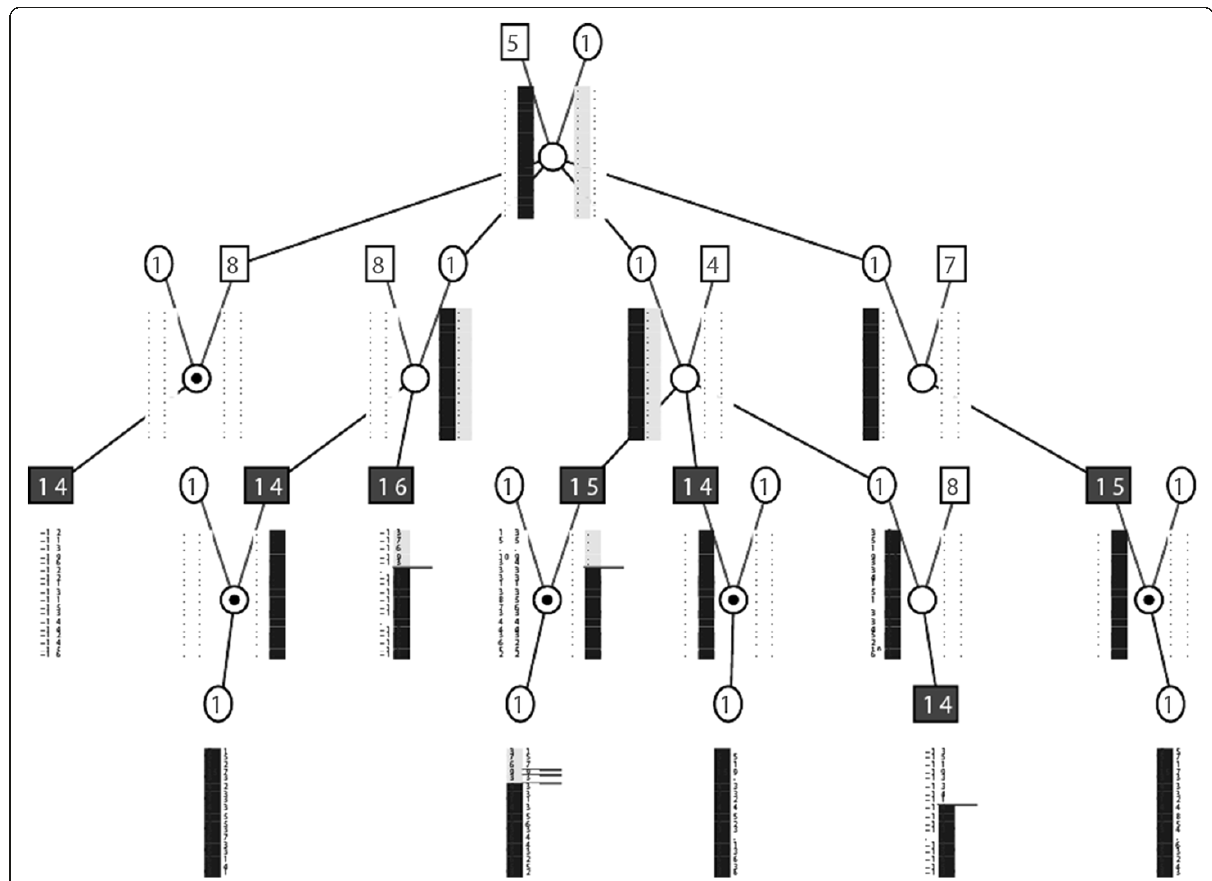
Figure 2 Pedigree that exhibits both potential male-to-male transmission and potential maternal inheritance of prostate cancer. In this family, with a maximum LOD of 1.7 in the HPCX region, all five maternally related affected males share a linked haplotype (shaded black) in this region and the one paternally-related affected male does not share this haplotype. The numbers in the shapes are liability classes based on affection status and